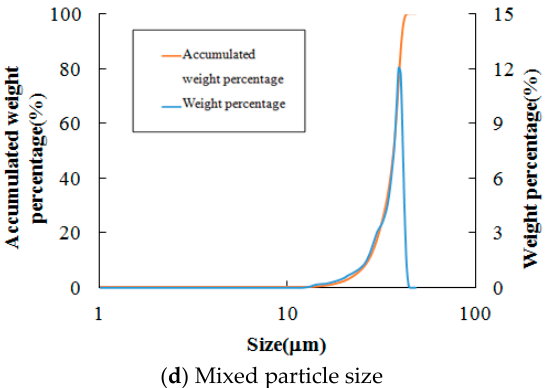
Figure 3. Weight percentage and accumulated weight percentage of different particle sizes.